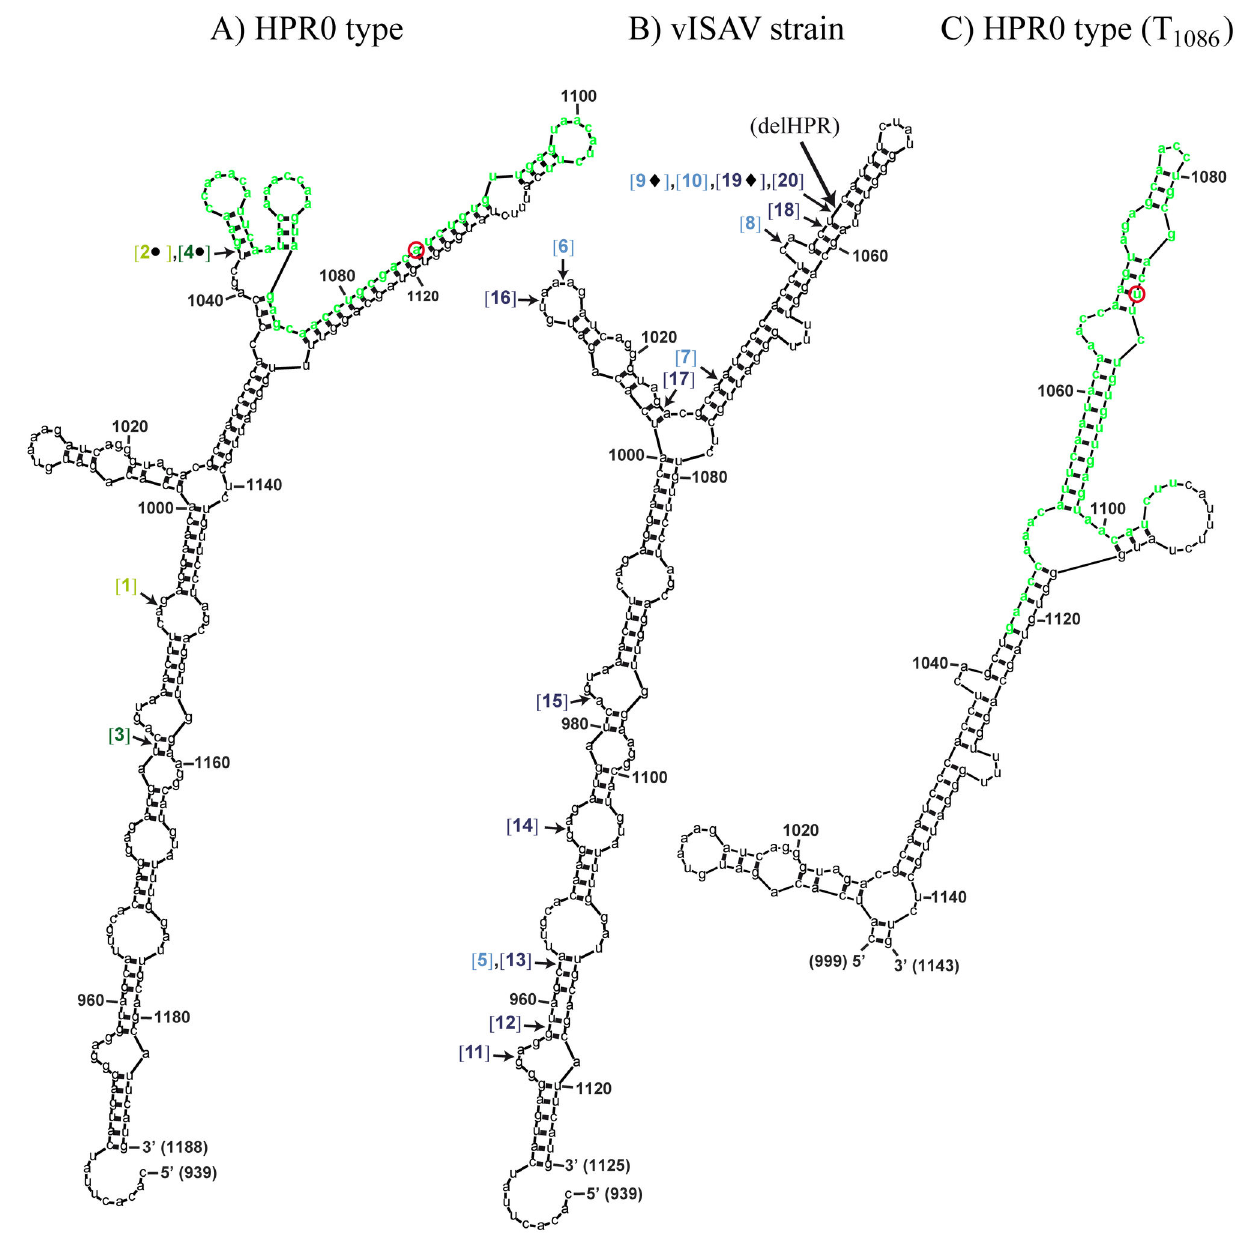
Figure 2. RNA secondary structure predictions of HE amplicons using mFold. The lowest free energy predicted structures of the RNAs in the sense (+) orientations are shown. A) Sanger sequence of non-virulent HPR0 strain, B) Sanger sequence of the virulent ISAV strain, and C) partial Sanger sequence from screening with a single A →T mutation (position indicated by red 1086 1086 circle in A) and C)). Default settings were used in the predictions, except for temperature which was set to 15°C. Sequence numbering is according to ORF . The nucleotides constituting the HPR0 full-length HPR in A) and C) are shown in green color, start and the site were this region is missing in the sequence from the virulent strain (between T -C ) in B) is indicated by a large 1043 1044 arrow and “delHPR”. Numbers in brackets indicate the 5’-flanking positions of deletion sites. Here, the numbering, symbols and color coding correspond to that used in Figure 1a